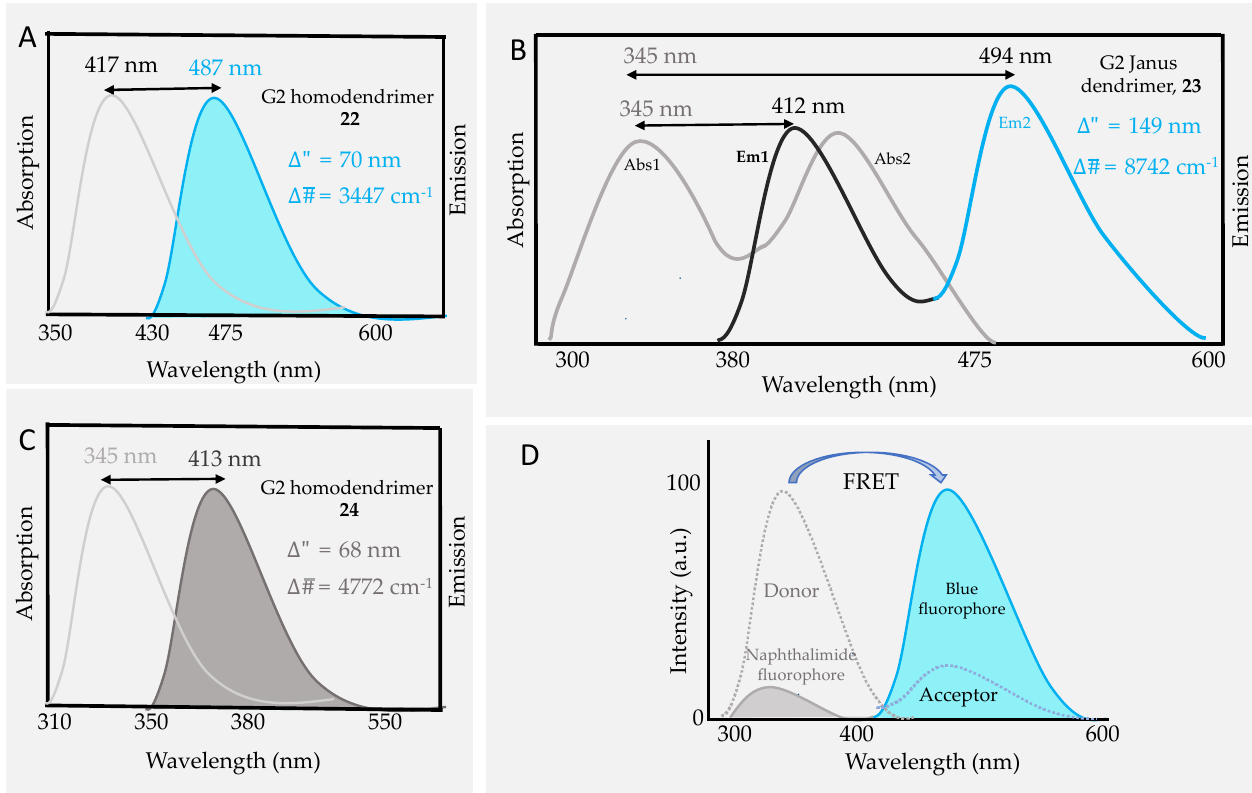
Figure 3. Representative Stokes shifts of G2 homo − and Janus dendrimers 22 – 24 ( A – C ) in 1:1 solution of DCM and methanol. The shifts are shown both in wavelength (nm) and wavenumbers (cm − 1 ) in the adjoining figure. The dimmed black curve represents absorption whereas intense black or blue curve shows fluorescence emission of the dendrimer. The bottom right figure ( D ) shows FRET phenomenon observed in G2 Janus dendrimer 23 . Abs = Absorption, Em = Emission.